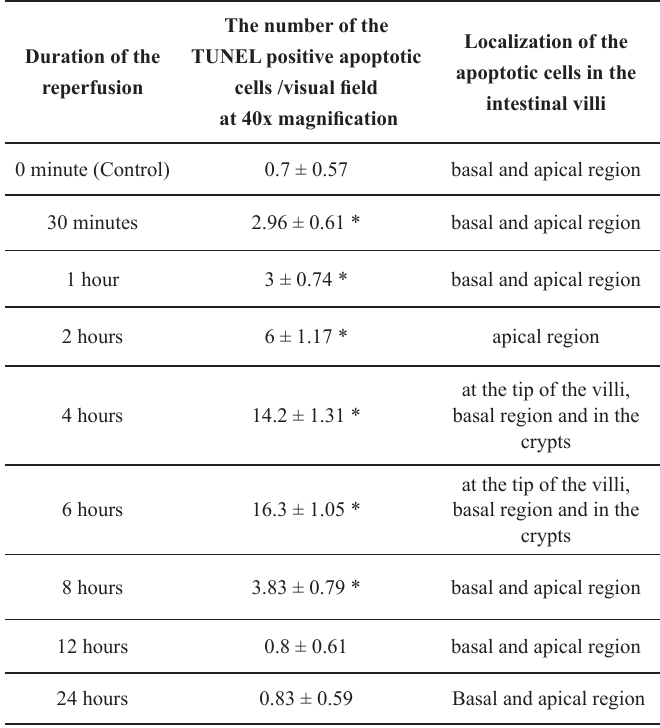
tABlE 1 - The number and localization of apoptotic cells in the function of reperfusion time.